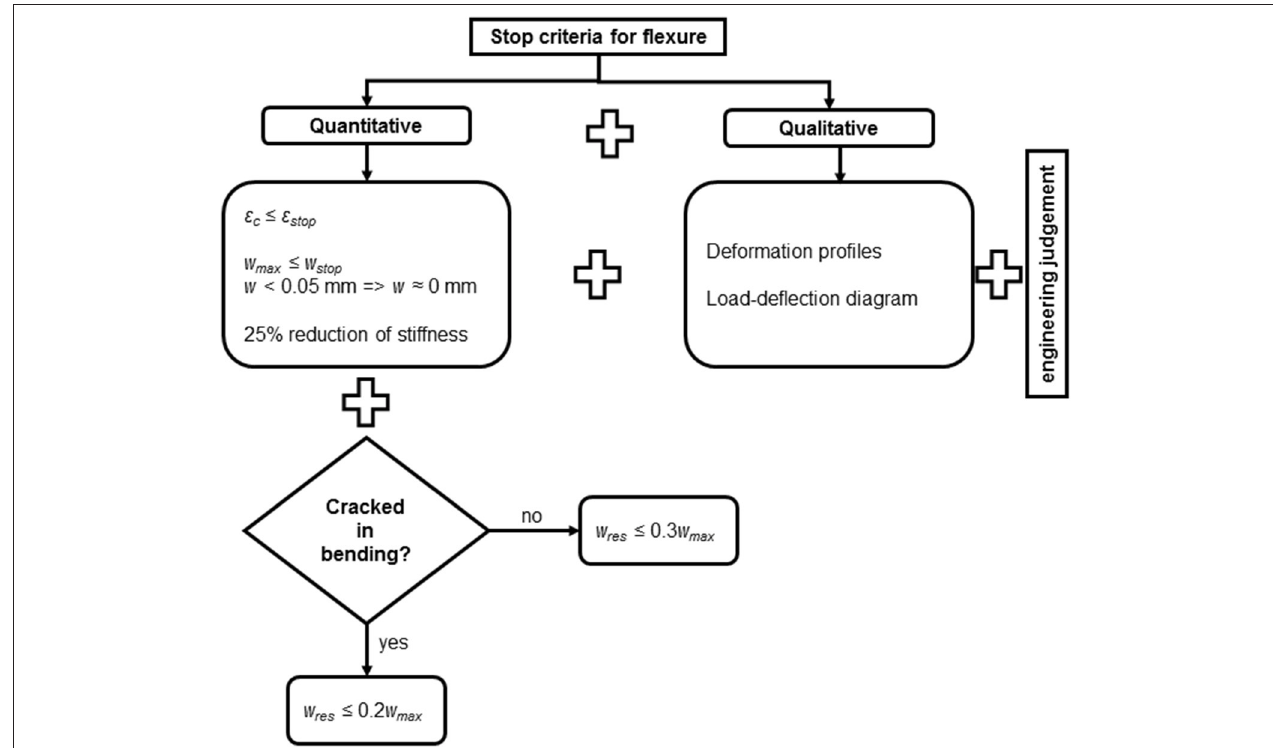
FIGURE 4 | Currently proposed stop criteria for